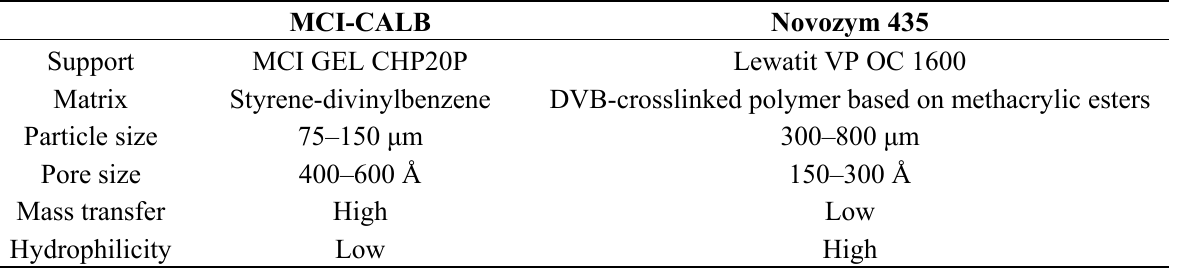
Table 2. Summary of the properties of the